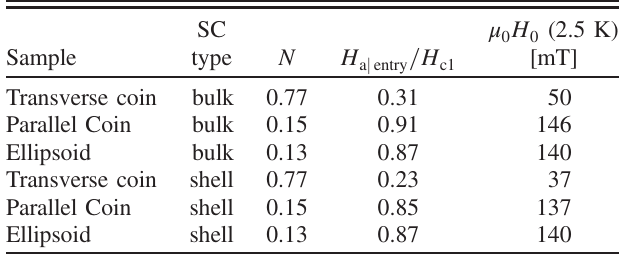
TABLE I. Geometrical normalizing factors for expected pin- free flux entry for the three sample types assuming μ H 0 K Þ ¼ 174 mT. For the shell geometry the edge 0 c 1 ð